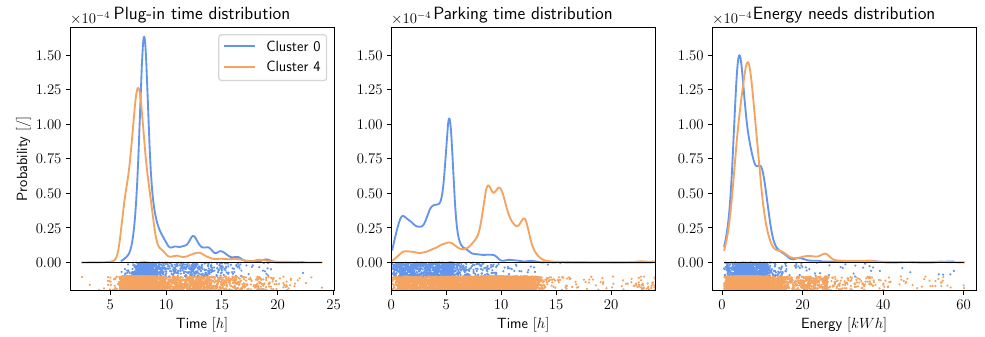
Figure 3. Results of the first clustering.